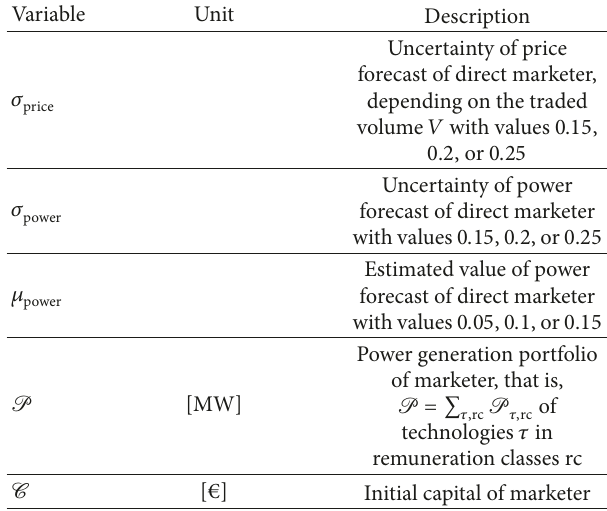
Table 2: Variables describing properties of direct marketers. Varia- tions of variable values are used to define the type of marketer and to reflect heterogeneity of